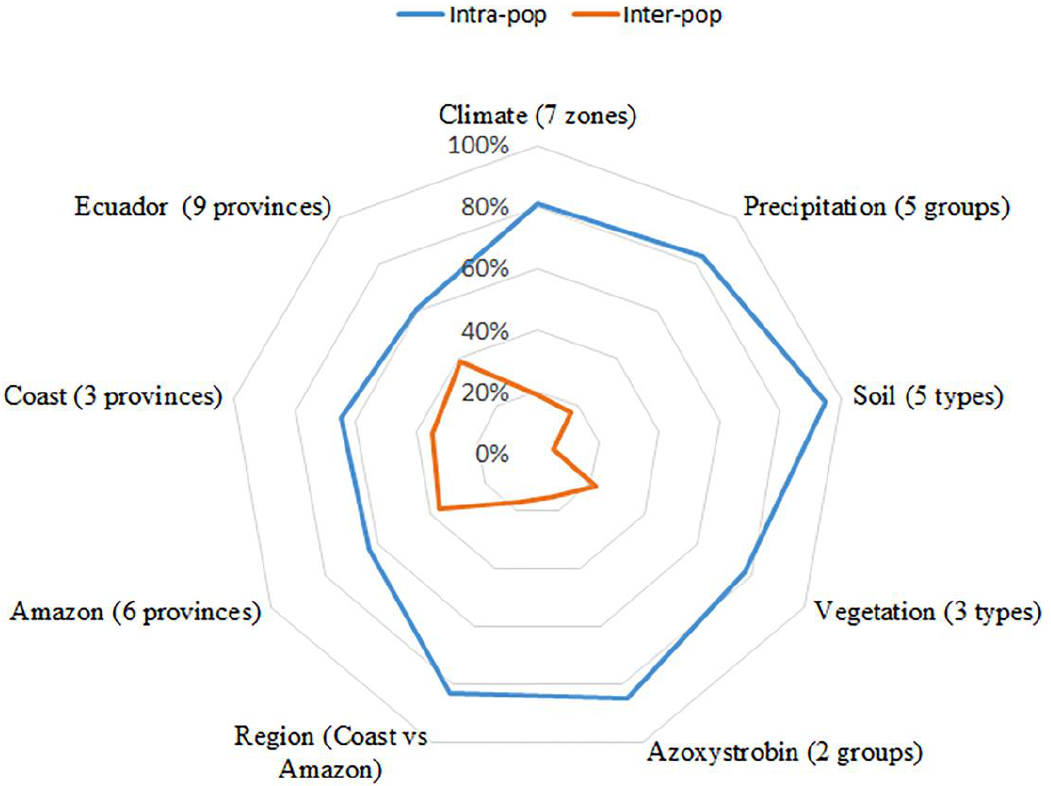
Figure 4. Summary of intra- and interpopulation of molecular variance analyses between populations of M. roreri . Subpopulations (groups) according to geographical, environmental, and phenotypic criteria (sensitivity to azoxystrobin) were delimited.